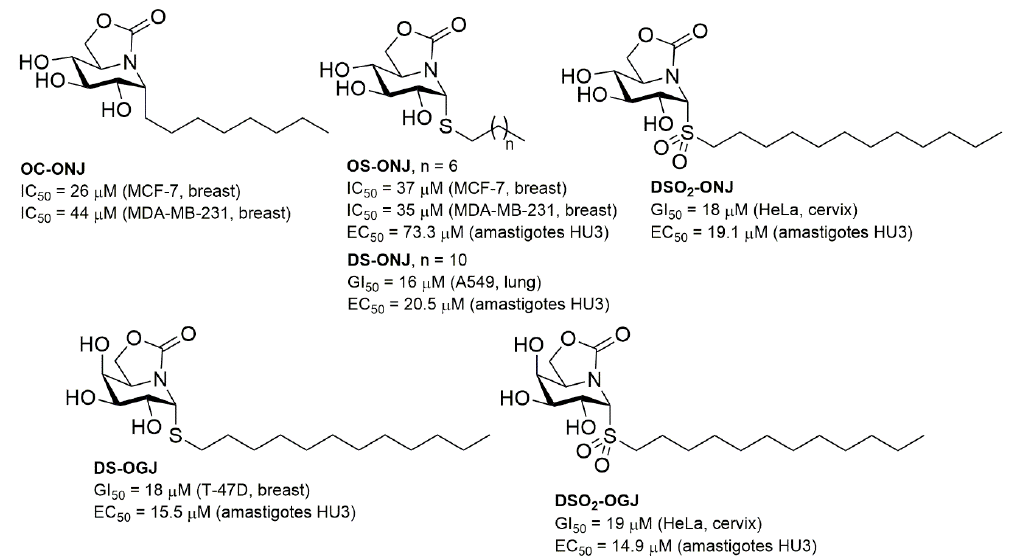
Figure 1. Chemical structures and biological activities of featured sp 2 -IGLs. Molecules 2018 , 23 , x FOR PEER REVIEW